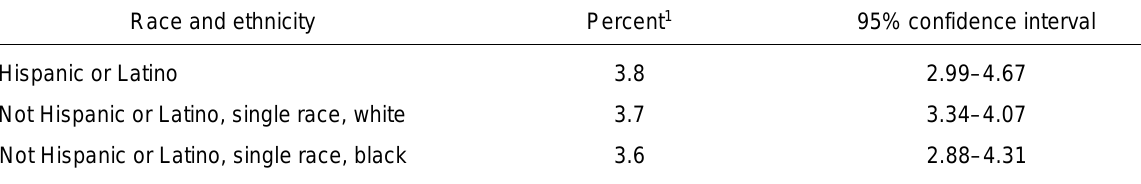
Data table for Figure 13.3. Age-sex-adjusted percentage of adults aged 18 and over who experienced serious psychological distress during the past 30 days, by race and ethnicity: United States,